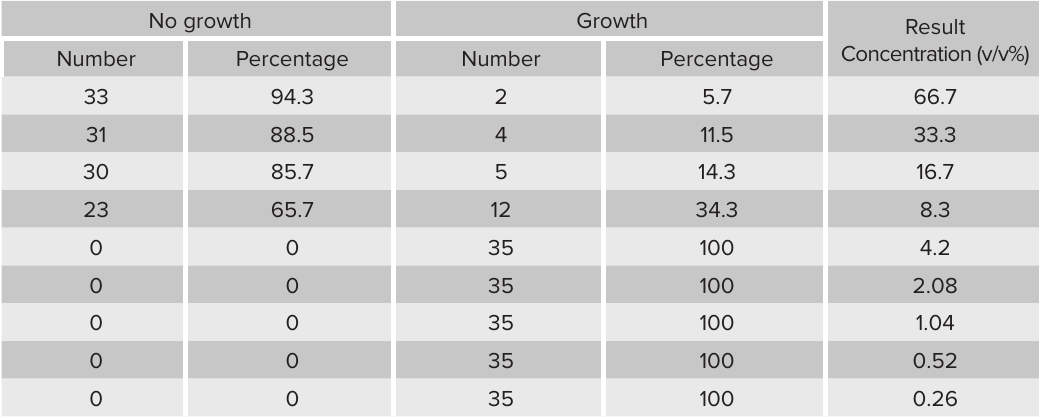
Table 3: Growth Rate of 35 Strains of Staphylococcus Aureus in Different Concentrations of Natural Hon- ey in Tubular Culture.